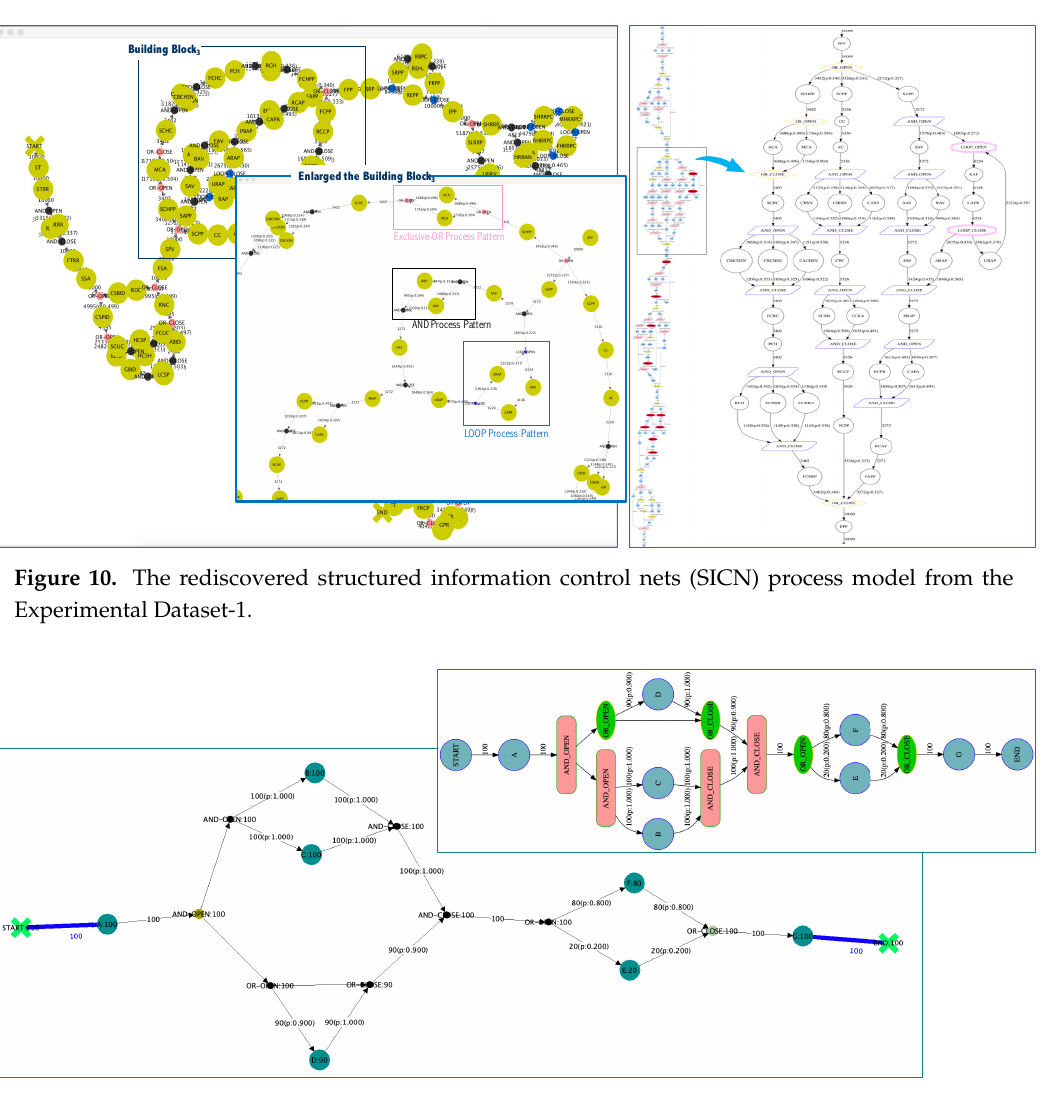
Figure 11. The rediscovered SICN process model with activities’ occurrences from the Experimental